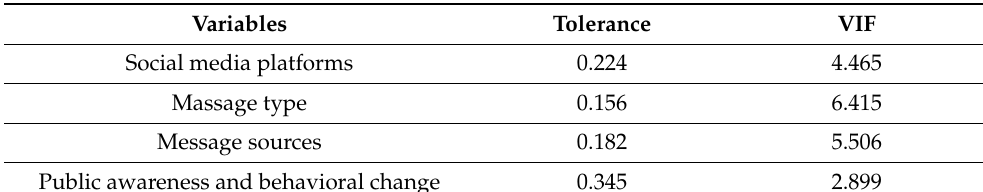
Table 4. Tolerance and VIF for the independent variables.